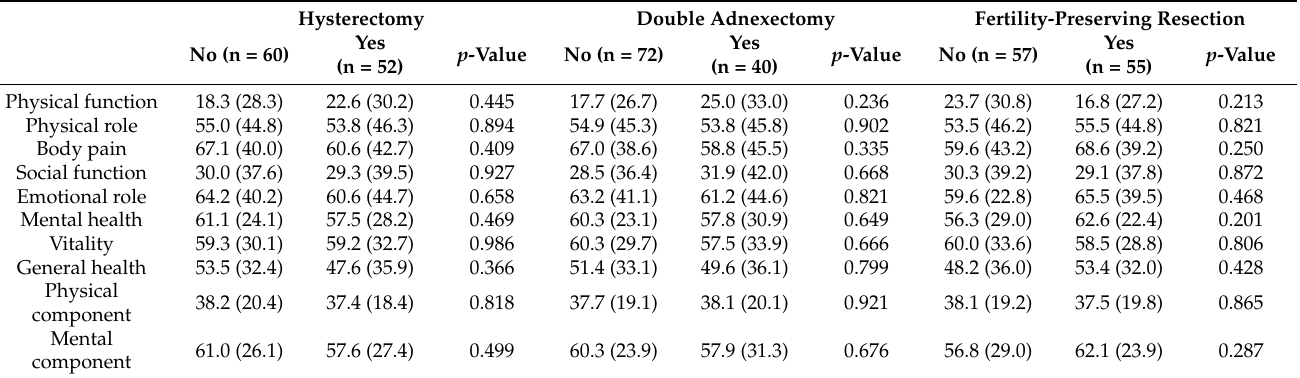
Table 3. Dimensions and components of SF-12 among women with or without hysterectomy, double adnexectomy, and fertility-preserving node resection.